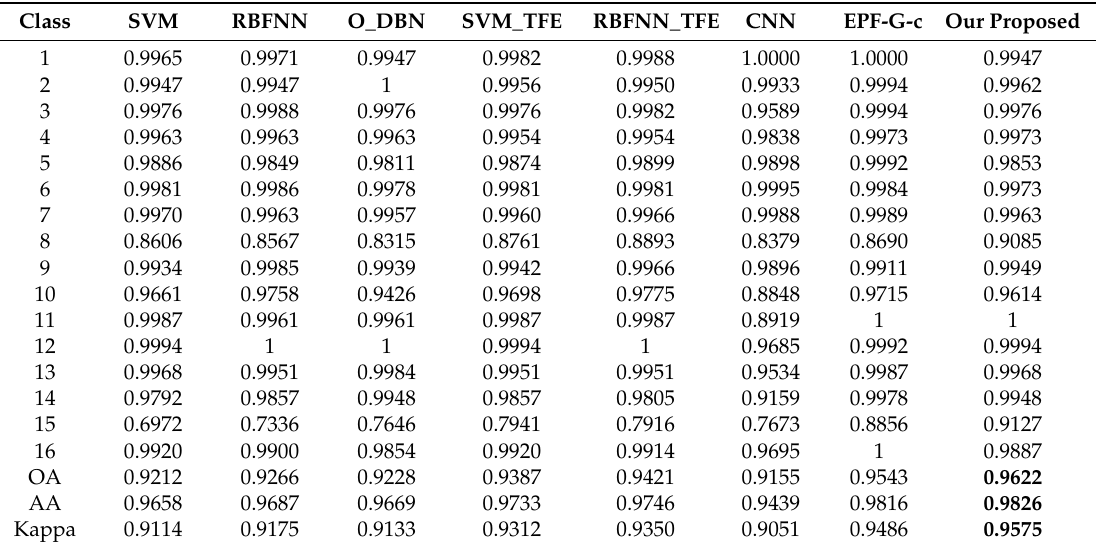
Table 10. Classification accuracy of different algorithms on Salinas Dataset.